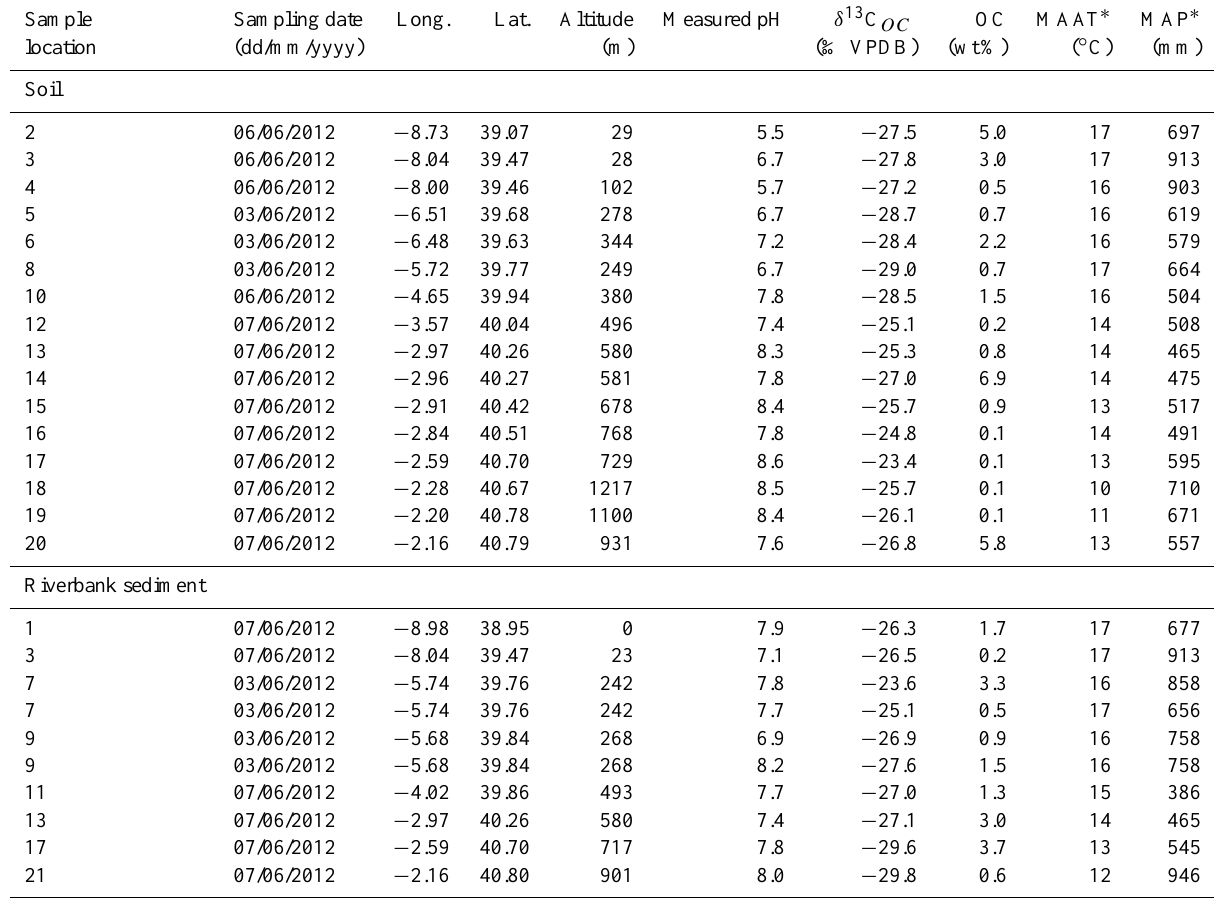
Table 1. Environmental and bulk geochemical data of soils and riverbank sediments collected in the Tagus River basin.